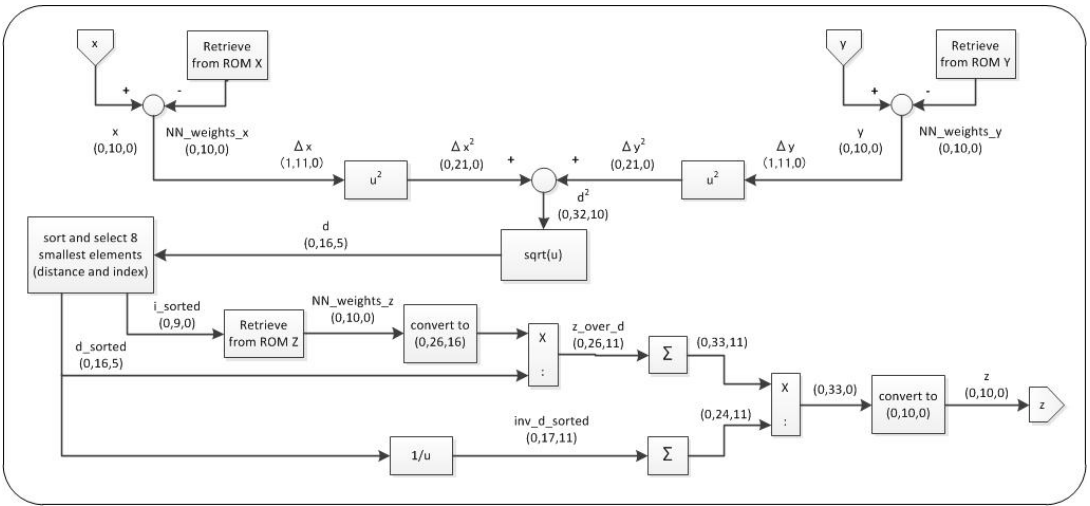
Figure 5. Synopsis of the recalling algorithm implemented on FPGA. Table 1. Comparison of requested and available resources.